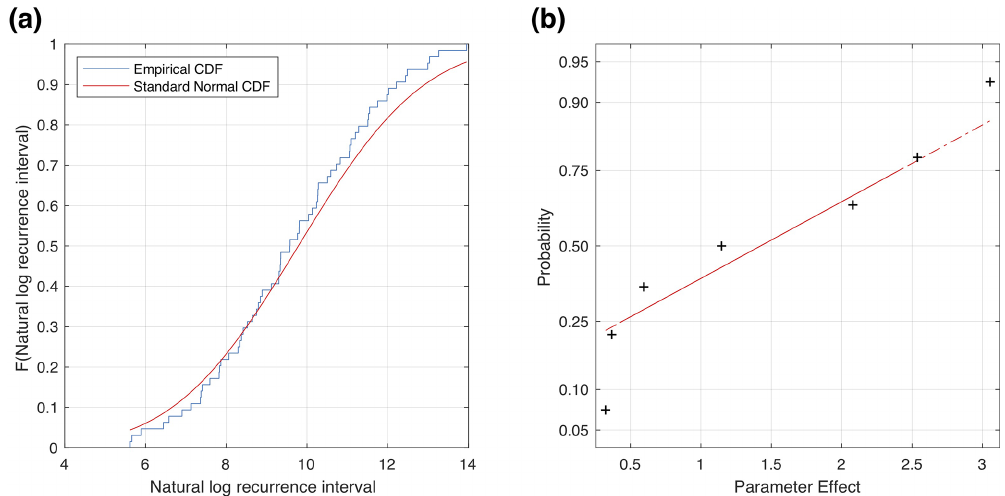
Figure A2. (a) Cumulative distribution function (CDF) of the natural log of the recurrence intervals calculated for the Chingale Step fault central section using the various parameter combinations listed in Table S1 (blue line). This CDF is compared to a standard normal CDF (red line) with the same mean value and standard deviation as the values in Table S1. (b) A normal probability plot of the parameter effects assessed in the sensitivity analysis and reported in Table 5. The most important effects are those that plot above a standard normal distribution (red line). The line is solid when within the first and third quartiles of data and is dashed when outside of this